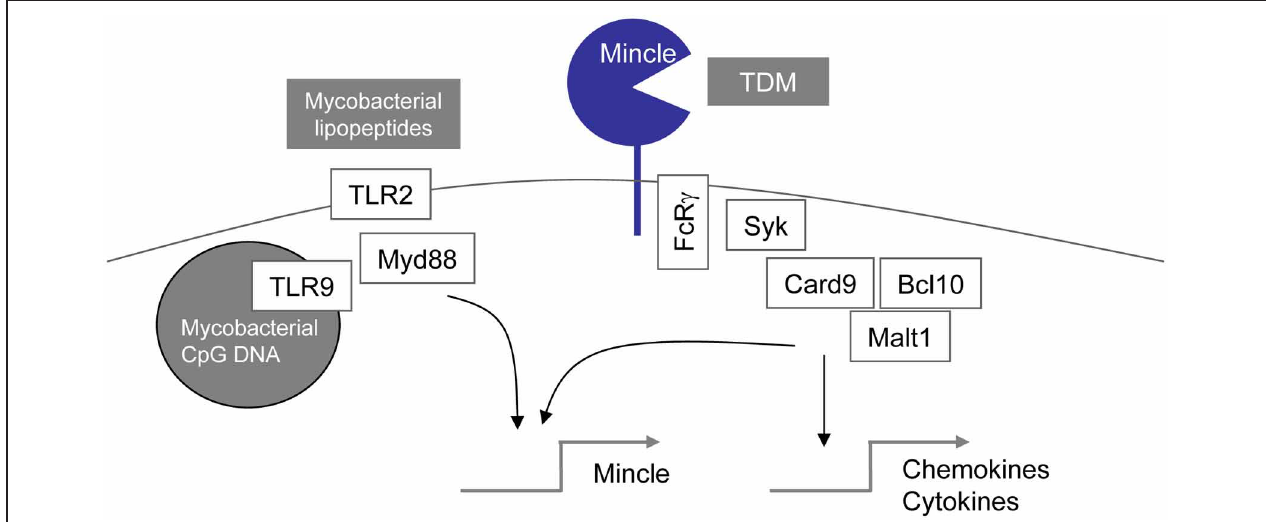
FIGURE 2 | TDM recognition and responses through regulated Mincle expression: possible synergy with TLR signals.